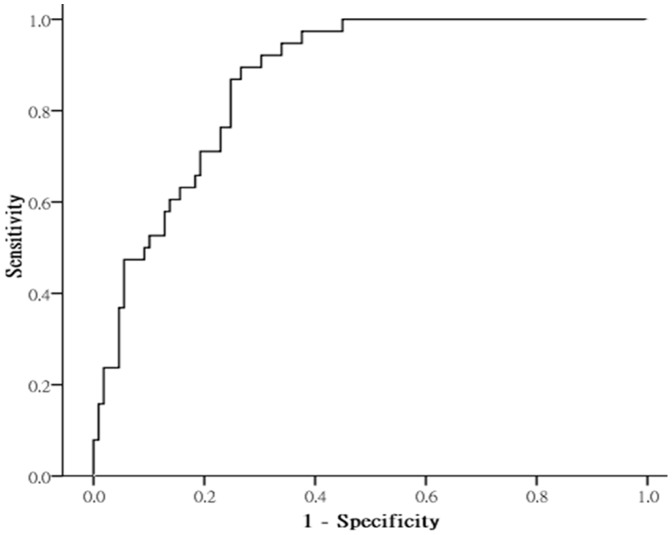
Receiver operating characteristic curve of pleural N-terminal pro-B-type natriuretic peptide levels comparing patients with pleural effusions caused by congestive heart failure to those with pleural effusions attributable to other reasons.The area under the curve was 0.87 (95% confidence interval 0.81–0.92).